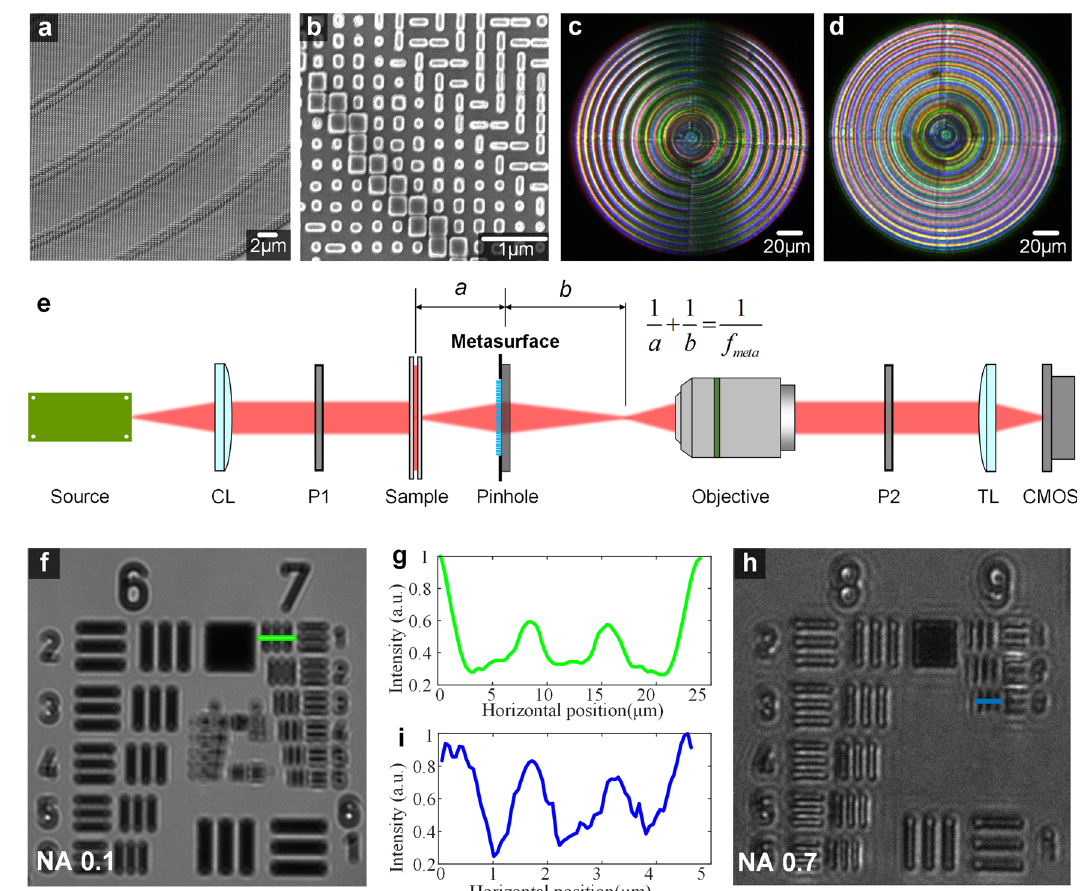
Fig. 2 | Characterization and performance tests of the metasurfaces. a , b SEM image of the fabricated metasurface. Images of a-DIC ( c ) microscopy and i-DIC ( d ) microscopy under white-light illumination in transmission mode. e The schematic con fi gurationofthemetasurfaceDICmicroscopy.CL,collimatinglens,P1andP2,a pair of crossed polarizers. TL, tube lens. CMOS complementary metal oxide